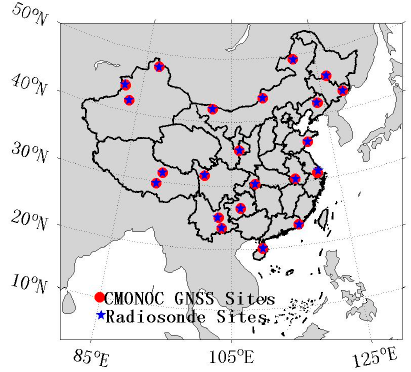
Table 3. Geodetic coordinates of RS sites and their nearby CMONOC GNSS sites.